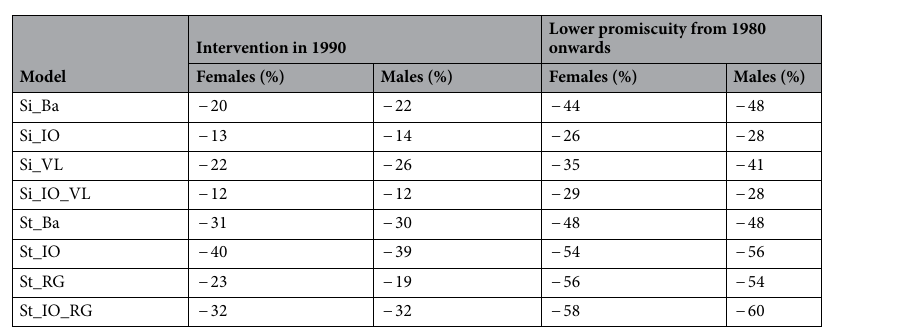
Table 5. Influence of interventions—relative difference in cumulative HIV incidence at the end of the study period (2005). Interventions were implemented as follows. For Simpact Cyan 1.0, the weight for the number of relationships a person already has (α_(numrel,man) = α_(numrel,woman) in formula (1)) was changed from 0 to − 0.05. For StepSyn 1.0, the proportion of male pending shorts links that are fulfilled by females (pending. short.links.fulfilled) was changed from 1 to 0.7. Median HIV incidence and range ([minimum,maximum]) of 100 simulations. Models abbreviations as in Fig.